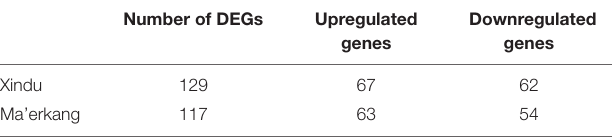
TABLE 1 | Number of differentially expressed genes between zws-ms and zws-217 in two environments. Number of DEGs Upregulated